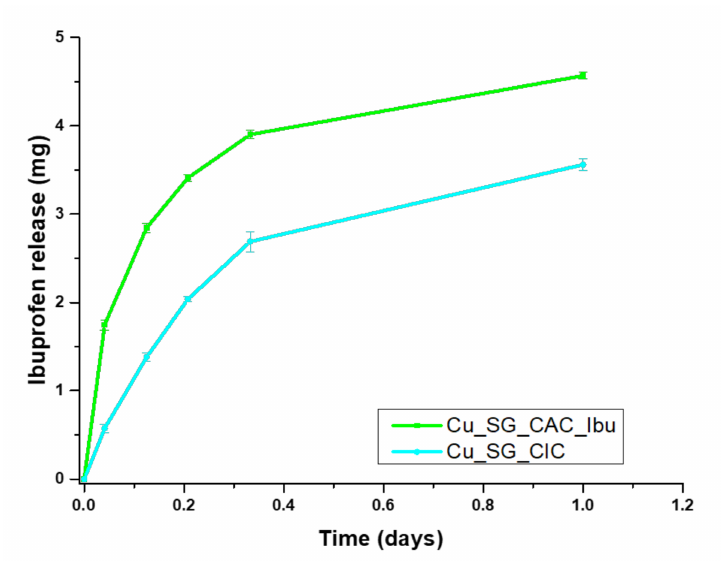
Figure 10. Ibuprofen release profiles of Cu_SG_CIC compared with Cu_SG_CAC_Ibu